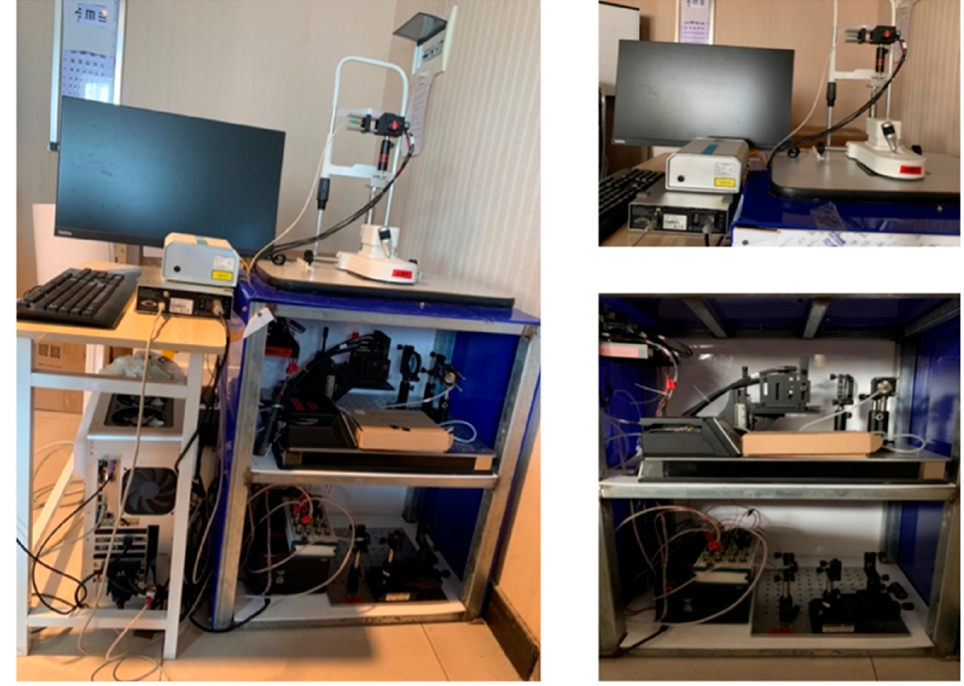
Figure 1. Photos of the clinic’s phenotype of phase-sensitive optical coherence tomography.